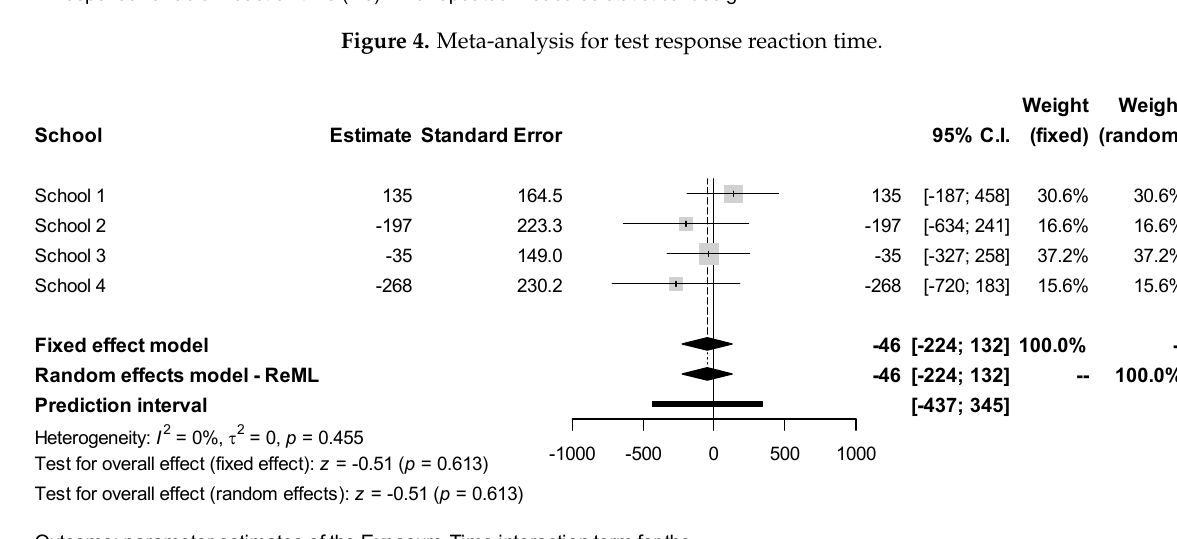
Figure 6. Meta ‐ analysis for test response reaction time variability. 4. Discussion The aim of this work was to study the relationship between carrying out an activity in a short period in a green space and the restoration of attention in seven ‐ year ‐ old chil ‐ dren. Although no interaction was found between exposure and time, after the activity— regardless of exposure—student responses improved in reaction time and reaction time variability. Previous studies have shown that long time exposure to green space can in ‐ fluence restoration of attention [37]; however, this study examined the effect that green space can have on restoring attention but found no effect. This result may be due to the fact that the study area is located in very green areas itself, as a consequence of being in the Atlantic climate: a temperate ‐ humid climate, showing moderate temperatures and be ‐ ing very rainy without a dry season. This combination favours the proliferation of vege ‐ tation [50]. In contrast, Dadvand’s [37] study area is a Mediterranean climate zone, with hot and dry summers and mild and rainy winters. In conclusion, there are fewer green areas compared to the Atlantic climate zones. In addition, other studies have found that more urbanised areas or city centres benefit more from the health effects of Green Spaces compared to rural areas, which may be due to the increased pace of life and stress that can occur in large cities [51,52]. Our study area consists of Zarautz, a town of around 23,000